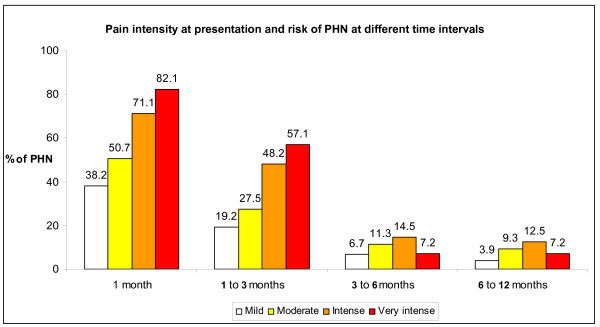
Pain intensity at presentation and the risk of PHN at different time intervals. Proportion of patients developing PHN at different time intervals according to pain intensity at presentation. Patients with PHN were 51.2% (n = 226) at one month after enrolment; 30.0% (n = 130) after one to three months; 9.8% (n = 43) after three to six months; 7.5% (n = 33) after 6 to 12 months.